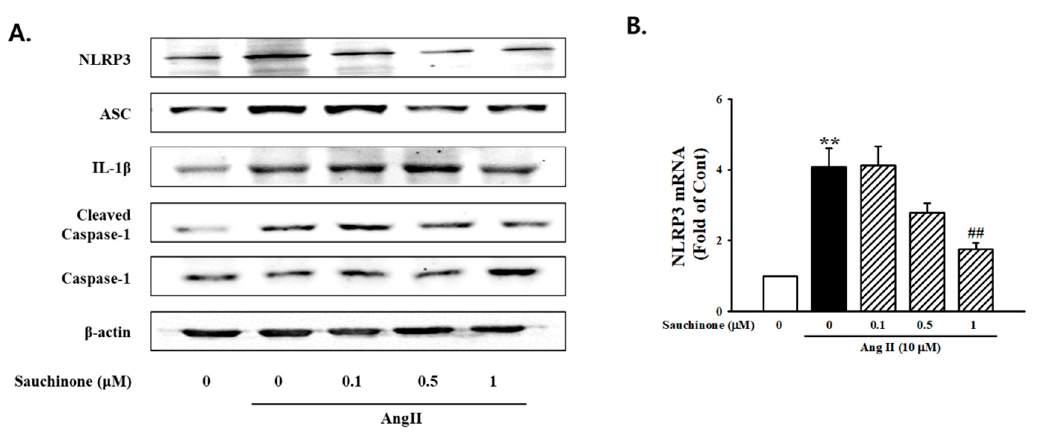
Figure 5. Inhibition effects of sauchinone on the NOD-like receptor family, pyrin domain-containing-3 (NLRP3) inflammasome in mesangial cells. ( A ) Western blotting and ( B ) real-time PCR showed protein and mRNA levels of NLRP3, ASC, IL-1 β , cleaved caspase-1, and caspase-1 in sauchinone-treated and AngII-stimulated cells at 48 h. β -actin or GAPDH were used as the internal standard in each sample. ** p < 0.01 vs. control and ## p < 0.01 vs. AngII alone.